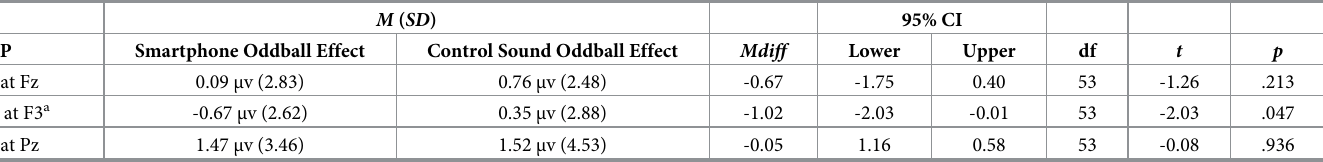
Table 8. ERP oddball effect between the smartphone and control sound trials. M ( SD ) 95% CI